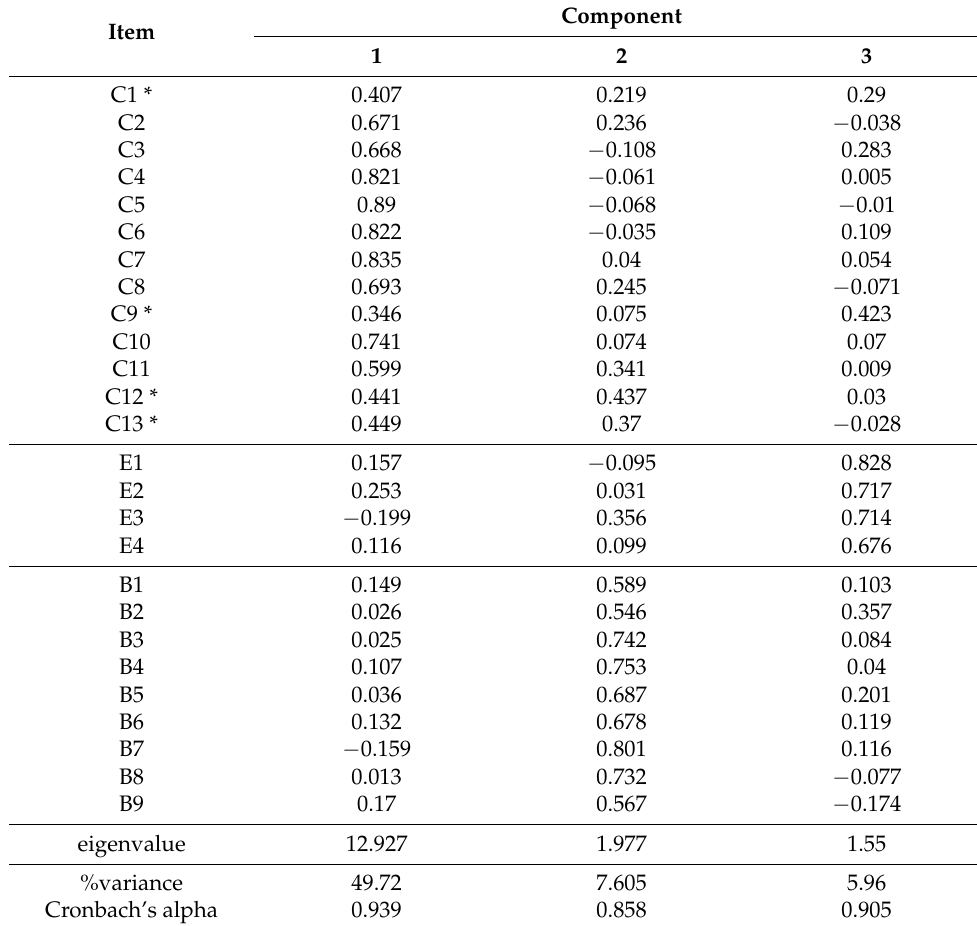
Table 6. The results of the exploratory factor